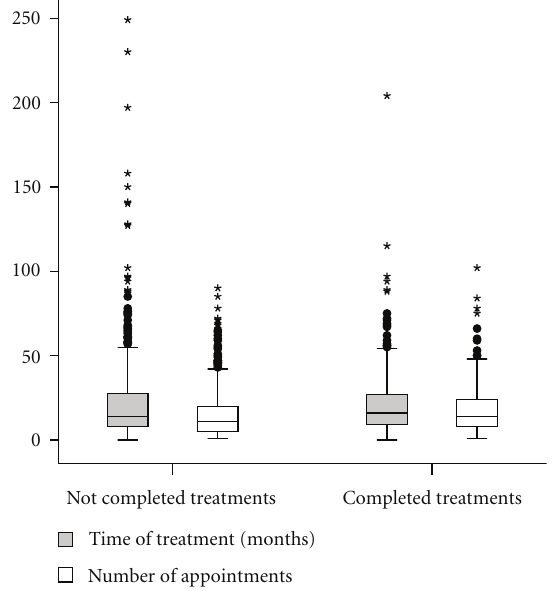
Figure 1: Box plot of frequency distribution for time of treatment (in months) and number of appointments for cases with completed and not completed treatments.